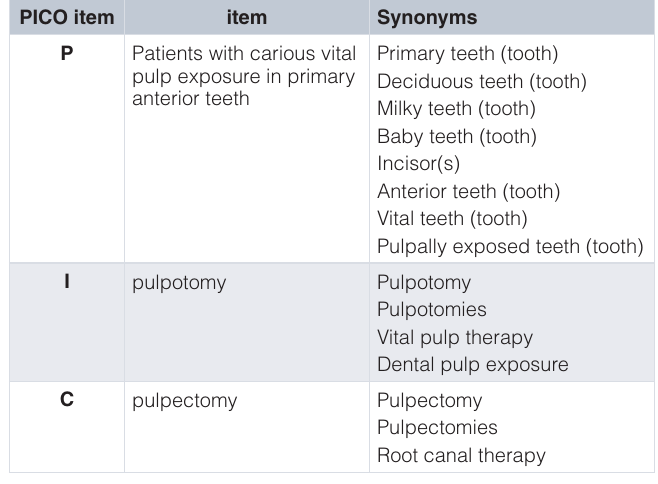
Table 1. Index terms used in search with